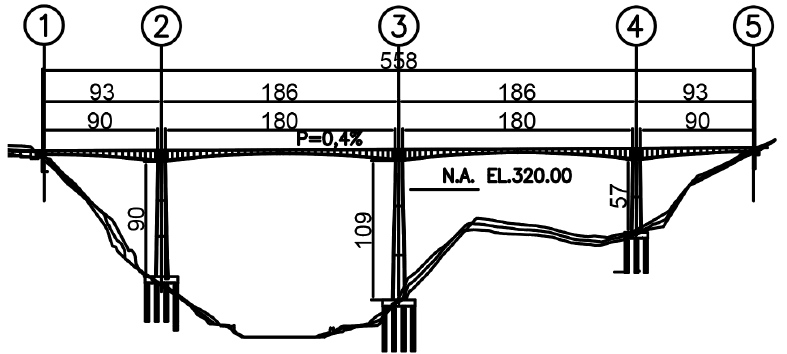
Figure 2. The Tablazo bridge side view.